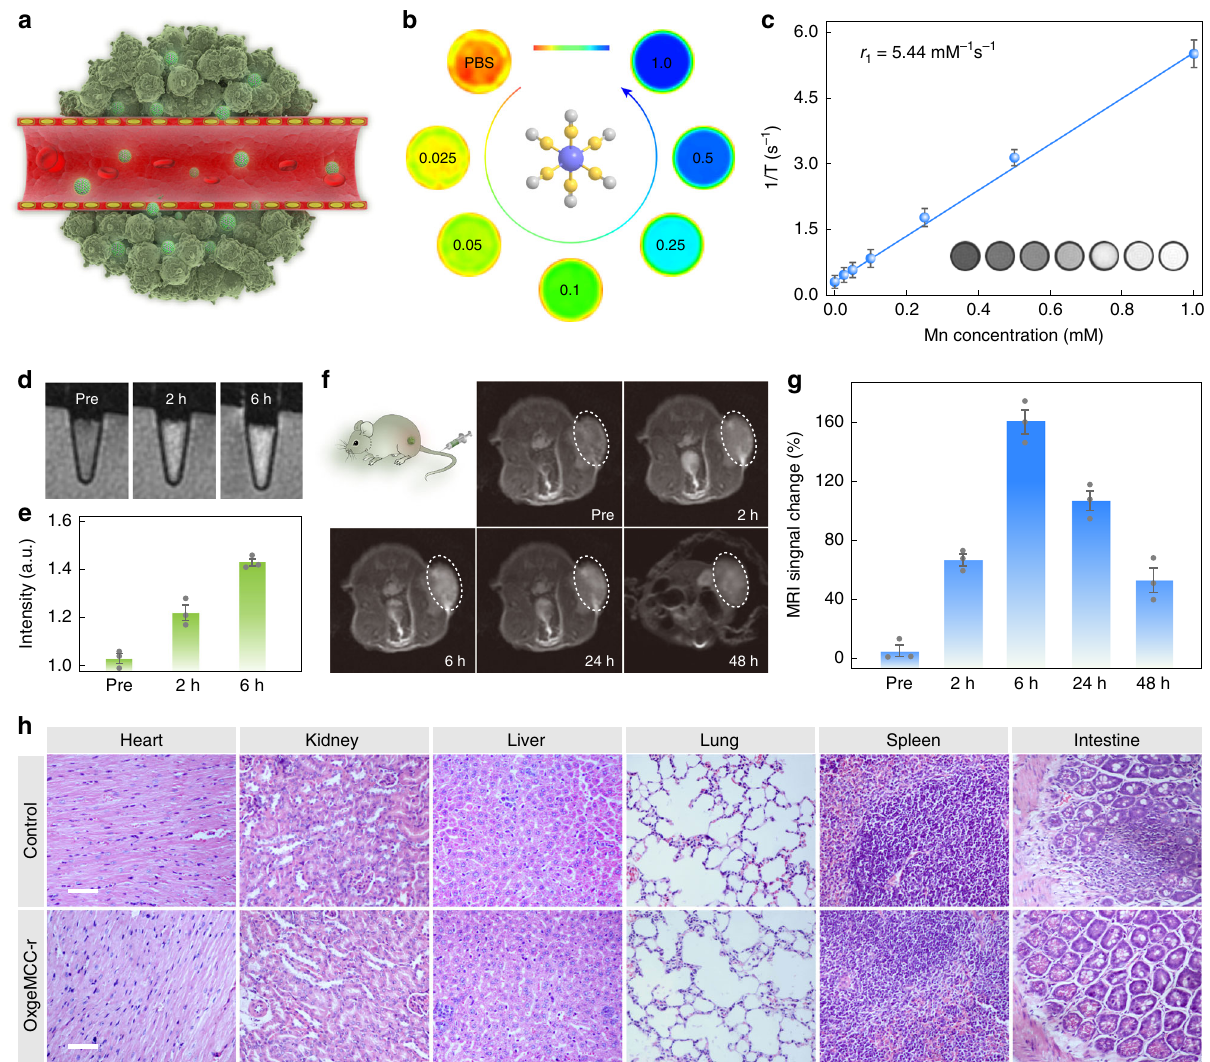
Fig. 7 In vitro/vivo MR imaging and biocompatibility of OxgeMCC-r SAE. a Accumulation of OxgeMCC-r SAE at the tumor site through the EPR effect. b In vitro T 1 -weighted magnetic resonance images of OxgeMCC-r SAE in aqueous solution with various Mn concentrations (mM). c Transverse relativity (r 1 ) value of 5.44 mM − 1 s − 1 for OxgeMCC-r SAE. Inset is magnetic resonance phantom images of OxgeMCC-r SAE. Data are presented as mean ± s.e.m. ( n = 3). d T 1 -weighted MR imaging of 4T1 cells treated with PBS, OxgeMCC-r SAE for 2 h, and OxgeMCC-r SAE for 6 h. e Corresponding relative MR imaging intensity of ( d ). Data are presented as mean ± s.e.m. ( n = 3). f In vivo T 1 -weighted magnetic resonance images of 4T1 tumor-bearing mouse at various time points post-injection. Tumor regions are marked with white dashed lines. g Quantitative T 1 -weighted MR imaging signals within the tumor site. Data are presented as mean ± s.e.m. ( n = 3). h Micrographs of major organs stained with H&E. Scale bar is 50 µ